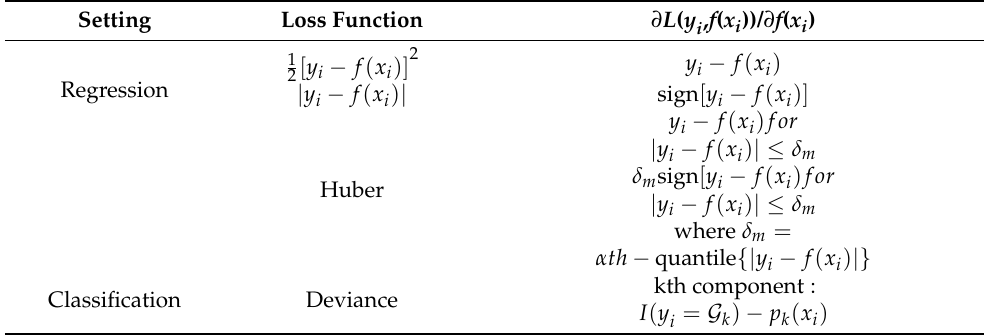
Table 2. GBDT Loss function